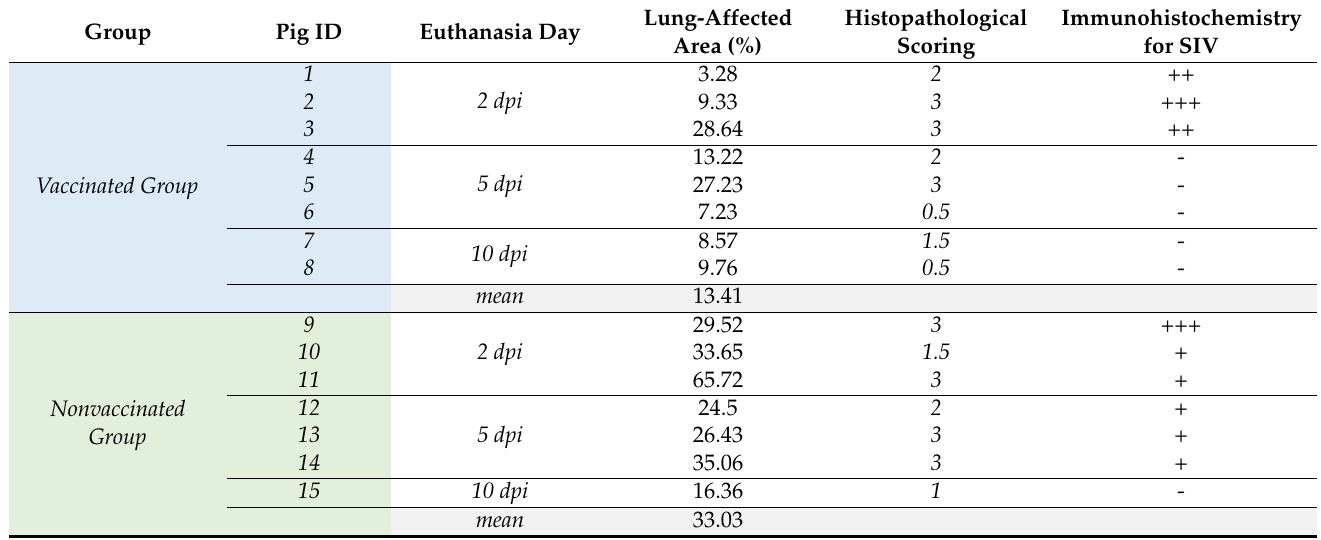
Table 2. Pathological results based on microscopic observation and quantitative scoring of HE and IHC staining lung samples, and percentage of lung-affected